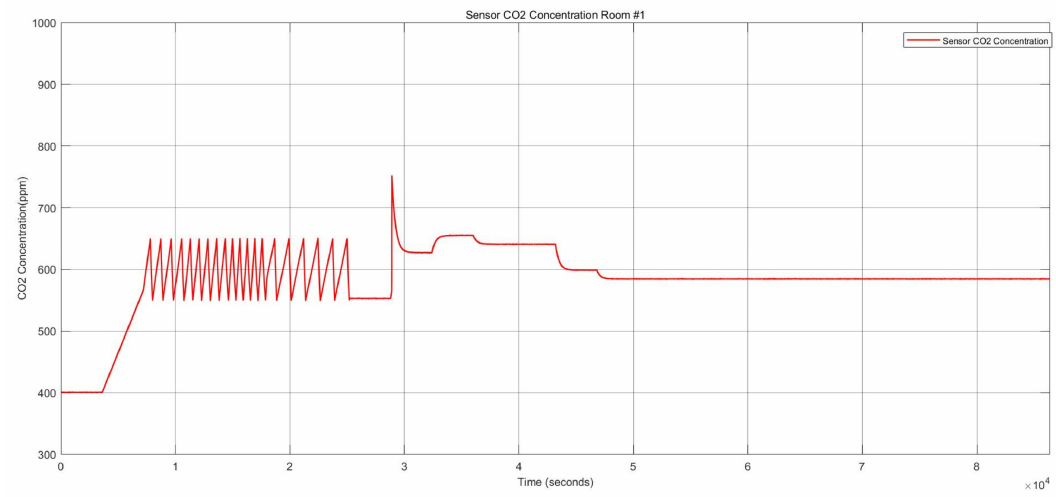
Figure 10. CO 2 concentration for the heater actuator and CO 2 sensor faults.